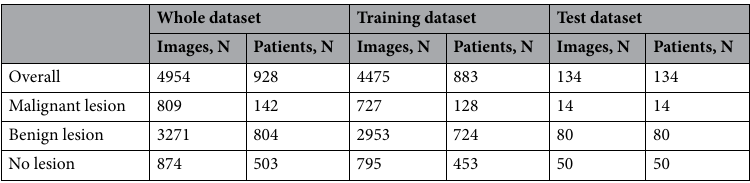
Table 1. Data composition of the constructed eyelid photograph dataset.